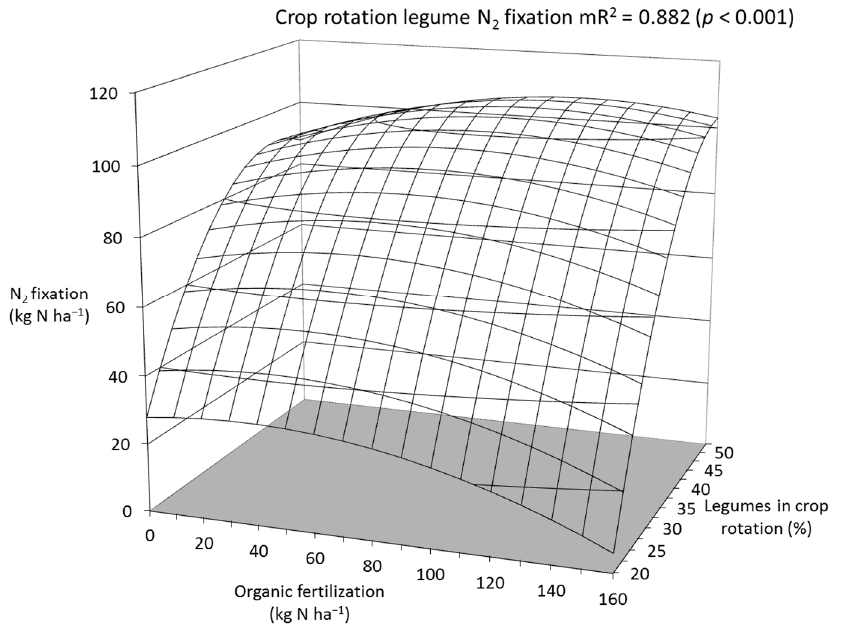
Figure 6. Effects of increasing organic N fertilization and legume proportions in crop rotations on the calculated N 2 fixation levels of legumes on heavy soils.